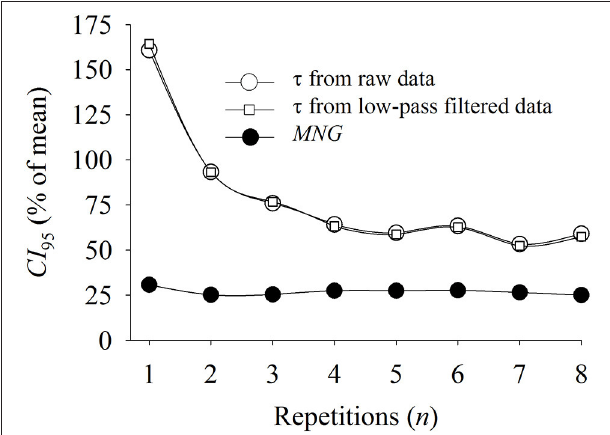
FIGURE 8 | Relationship between the confidence interval ( CI 95 , reported as percentage of the mean) of the time constant ( τ ) and mean normalized gain ( MNG ) obtained from different numbers of exercice repetitions. The τ was obtained from raw and filtered (0.075 Hz) oxygen uptake data. The τ CI 95 stabilized at ≈ 70% after four exercise repetitions while the MNG CI 95 was constant at ≈ 30% across all exercise